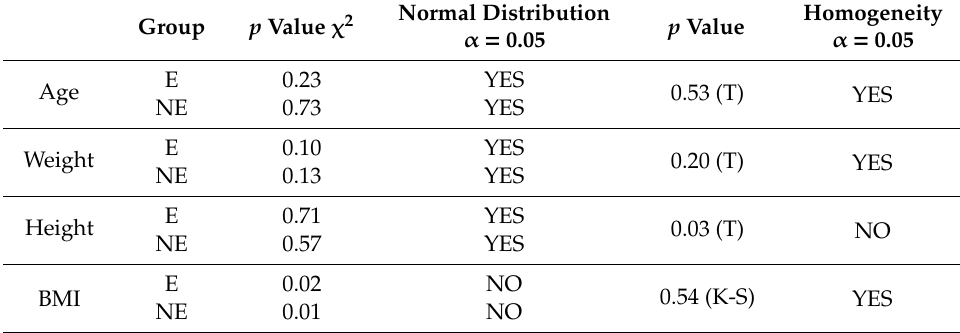
Table 1. Chi-square test for normality ( χ 2 ) results and a comparison between the E and NE group